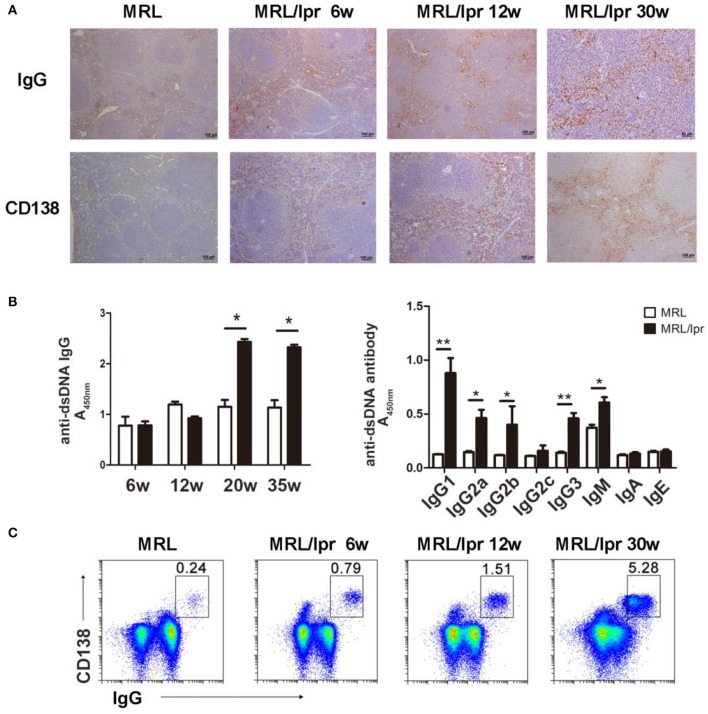
IgG production and deposition in the spleens of lupus mice. (A) IHC showing that IgG and CD138 are distributed in the splenic red pulp in 6-, 12-, and 30-week-old MRL/lpr mice. (B) Serum levels of the anti-dsDNA antibody in MRL/lpr mice (left panel) at different ages (6, 12, 20, and 35 weeks). Levels of anti-dsDNA antibody immunoglobulin isotypes in 35-week-old MRL/lpr mice (right panel). *P < 0.05, **P < 0.01. (C) Flow cytometry analysis of IgG-secreting plasma cells (IgG+CD138+) in 6-, 12-, and 30-week-old MRL/lpr mice. The results are representative of three independent experiments, n = 4–5 mice per group.